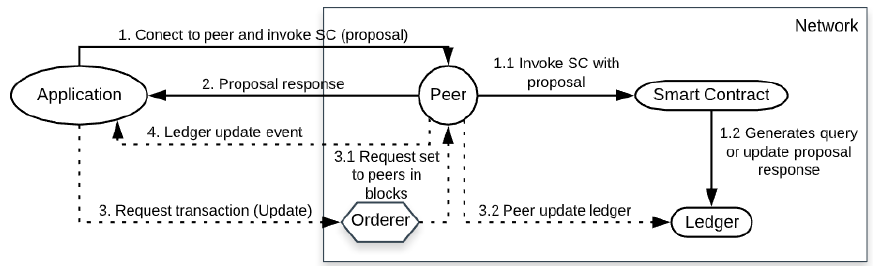
Figure 10. Application and peers interaction for queries and updates.